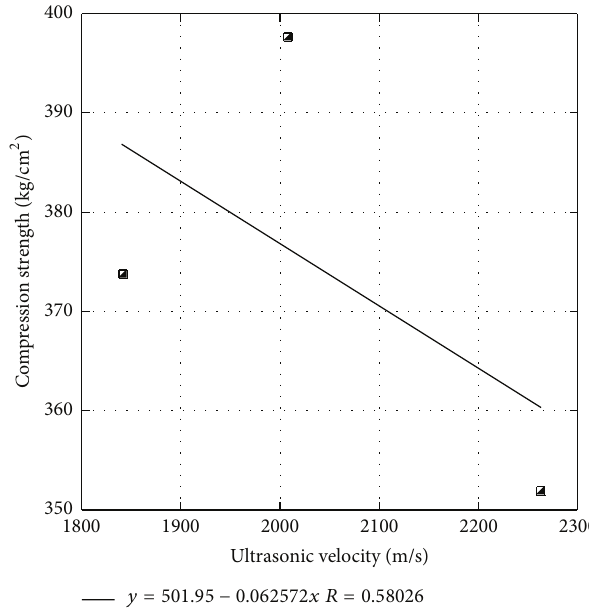
Figure 11: Correlation between UPV and compression strength for train E/F.